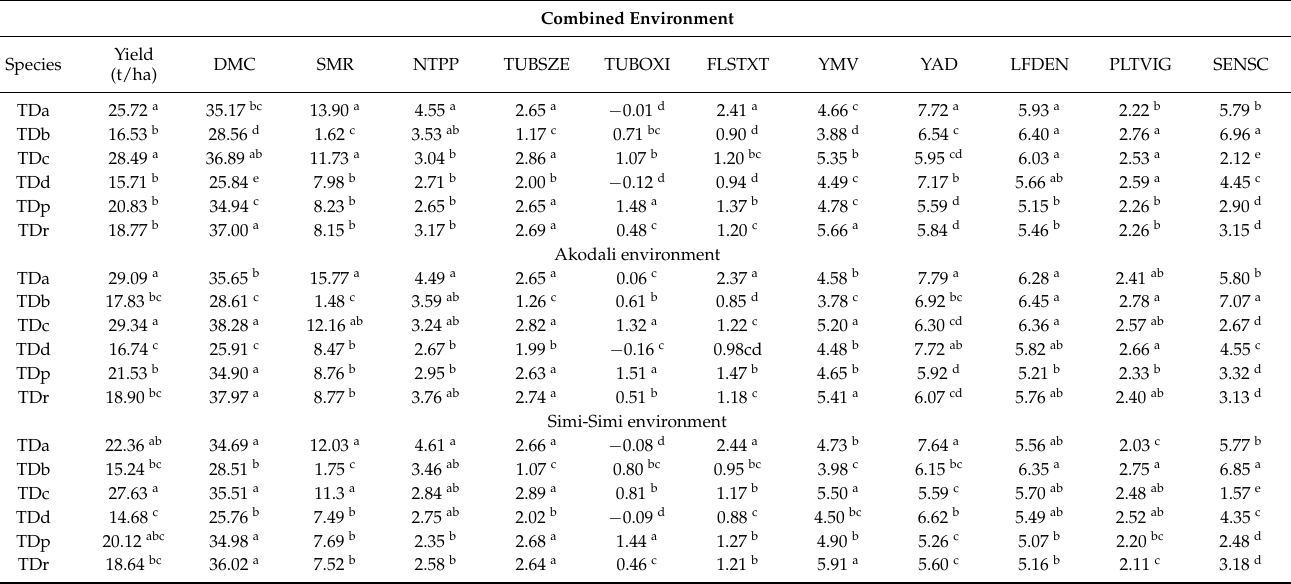
Table 4. Mean variations in agronomic and tuber quality traits of yam genotypes based on landrace